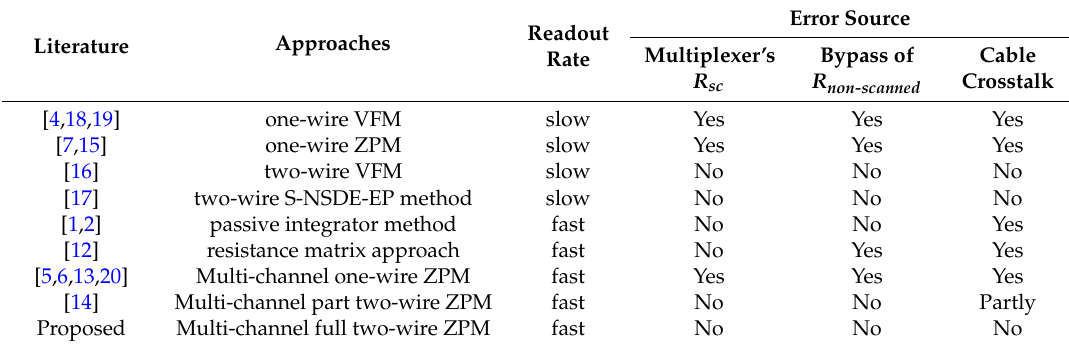
Table 1. Comparison of different readout approaches of the 2D resistive sensor